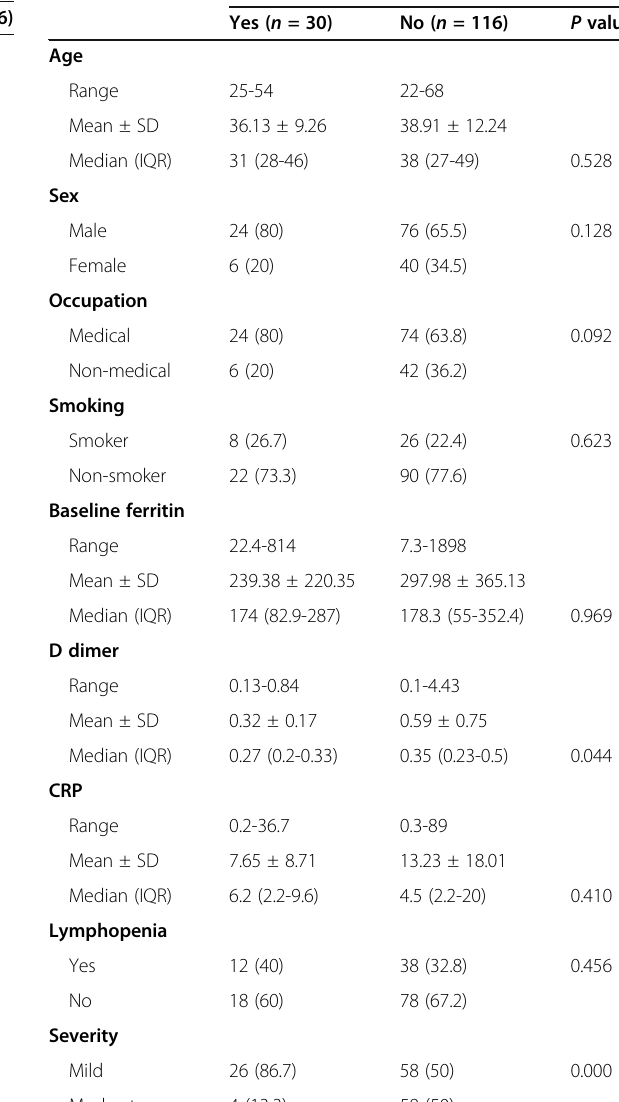
Table 1 Demographic, laboratory, clinical, and radiologic assessment of patients